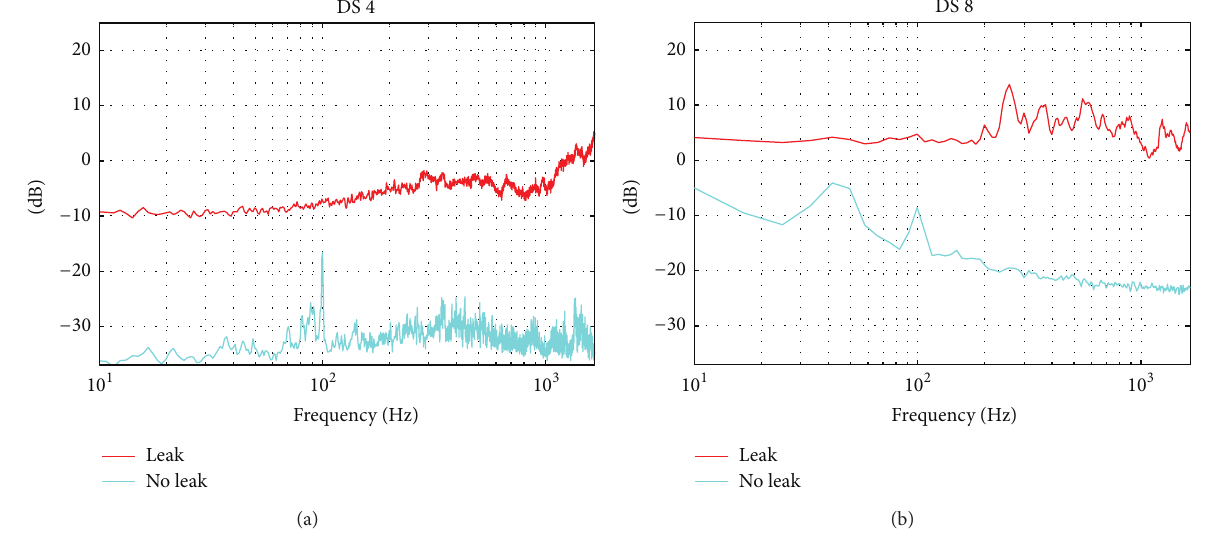
Figure 8: PSD of aggregated signals from datasets (a) DS 4, (b) DS